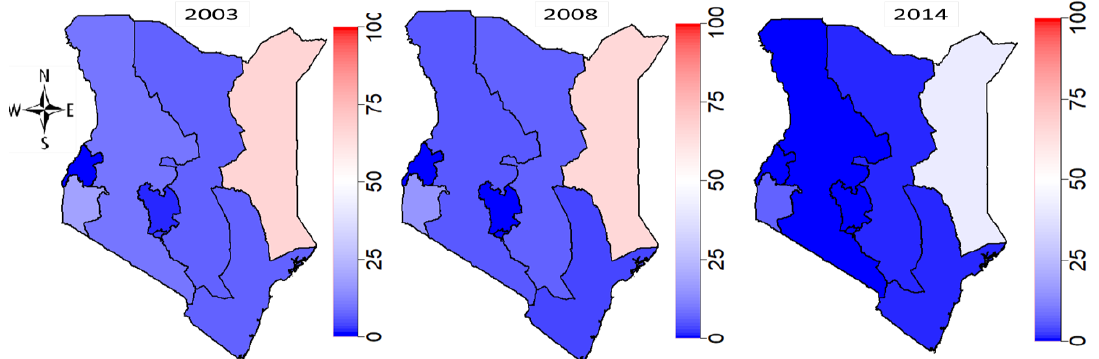
Figure 7. Predicted fully adjusted FGM/C prevalence among 0 – 14 years old girls in Kenya from 2003 to 2014 from the best fit model (Model III) of the pooled 2003 to 2014 data. Across the years, red regions had highest prevalence, while deep blue regions had lowest prevalence.